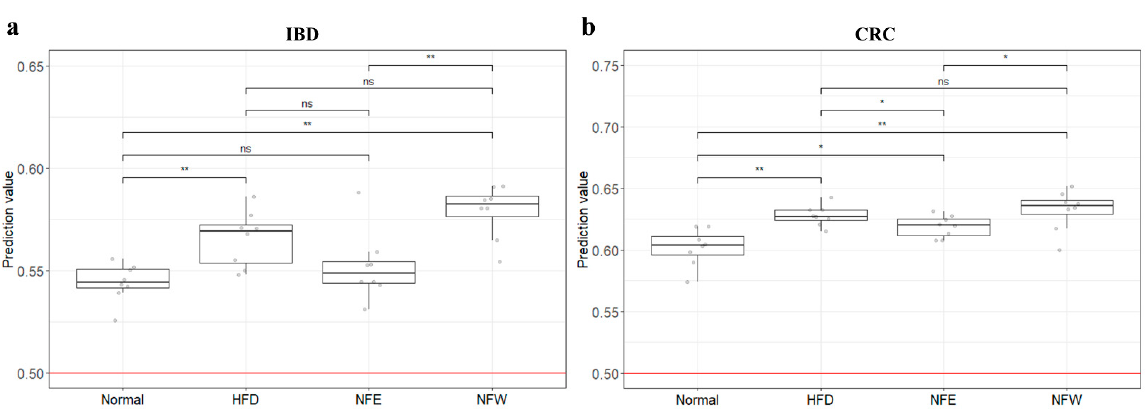
Figure 6. Risk prediction values of IBD and CRC models for rat groups. Predicted values of IBD ( a ) and CRC ( b ) risk were plotted as boxplots for normal, HFD, NFE, and NFW rat groups (*, p < 0.05; **, p < 0.01).